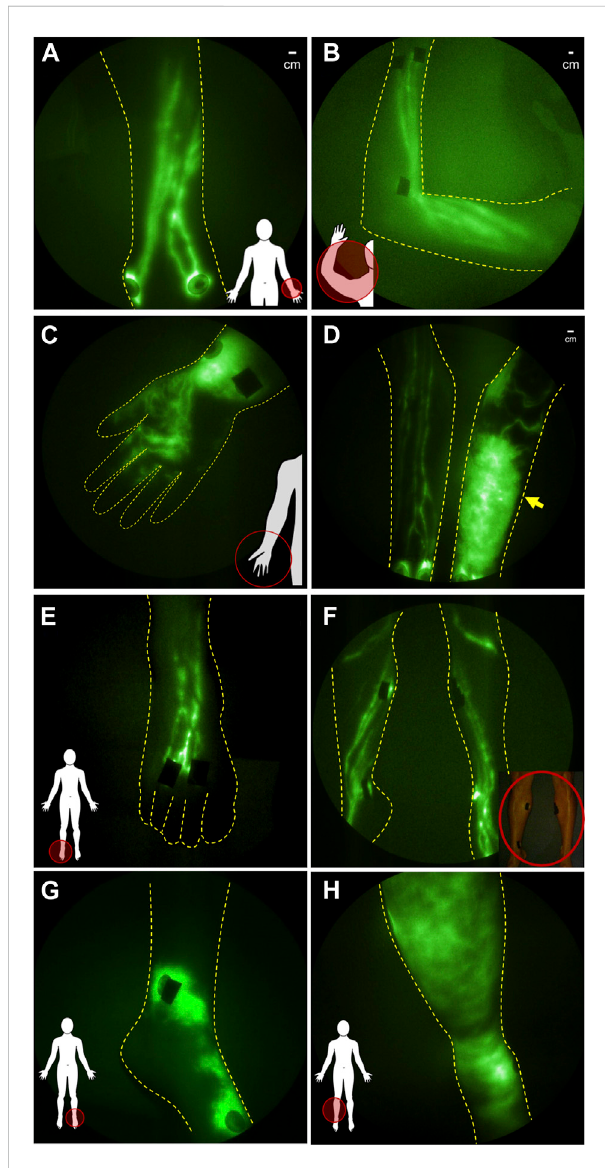
FIGURE 4 NIRF-LIstudiesoflymphaticdrainagein (A) dorsalaspectofhand and (B) in arm of healthy normal control volunteers. (C) Distal fl ow to the palm of the hand and (D) dermal back fl ow in the forearm of affected arm compared to the normal lymphatic anatomy and function in the contralateral unaffected arm of breast cancer related lymphedema subjects. NIRFL-LI studies of lymphatic drainage in the (E) dorsal foot and (F) legs of health normal subjects and dermal back fl ow in (G) the foot and (H) lower extremity of patients treated with inguinal lymph node dissection and radiation